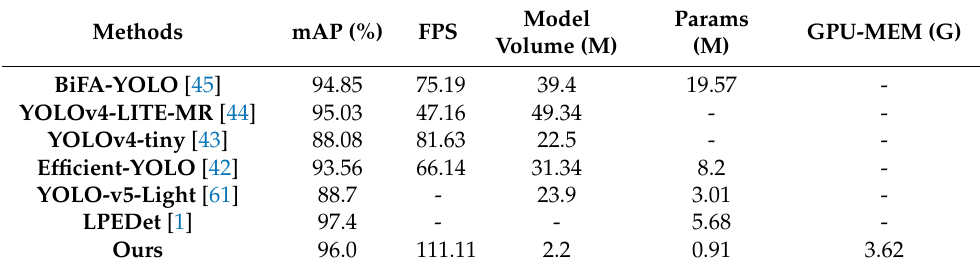
Table 5. Comparison between lightweight detection methods on the SSDD